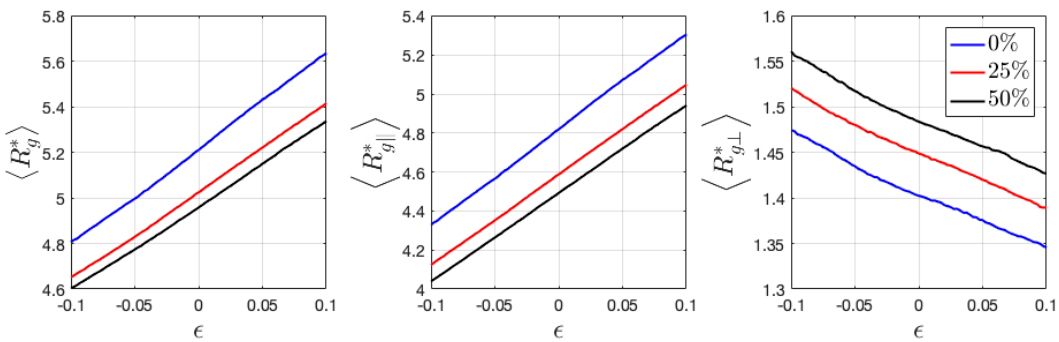
(cid:105) g (cid:107)